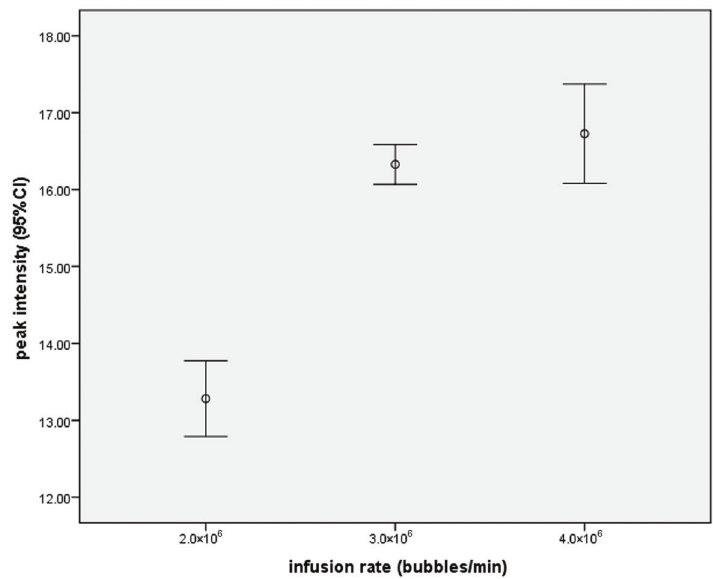
Figure 3. Hepatic perfusion parameter (peak intensity) error bars of different contrast agent perfusion rates. Each bar represents the average